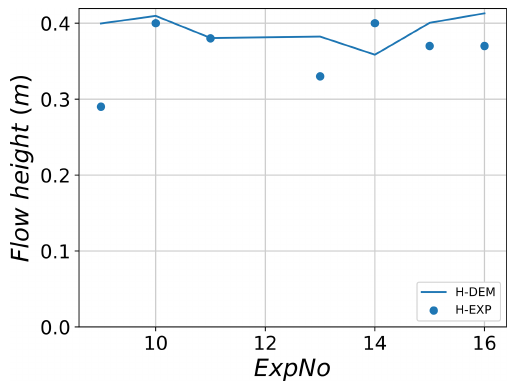
Figure 14. Variation in flow height, velocity and pressure for dif- ferent values of inclination angle ( α ) when normalized by results Figure 15. Maximum flow height at section 2 for experimental √ k 1 /k 2 = 0 . 3, d 50 = 75mm and of the simulation with φ b = 30 ◦ , data (H-Exp) and their corresponding best-fit DEM simulations (H- α = 30 ◦ . DEM).